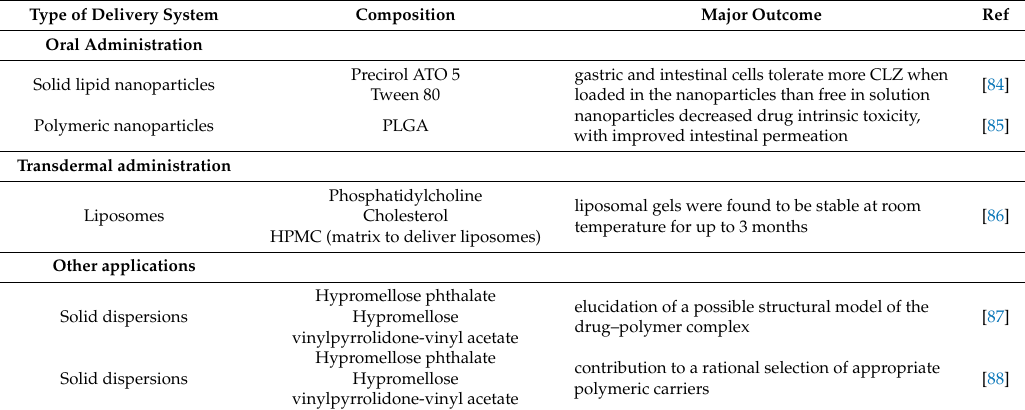
Table 2. Clofazimine drug delivery systems for leprosy